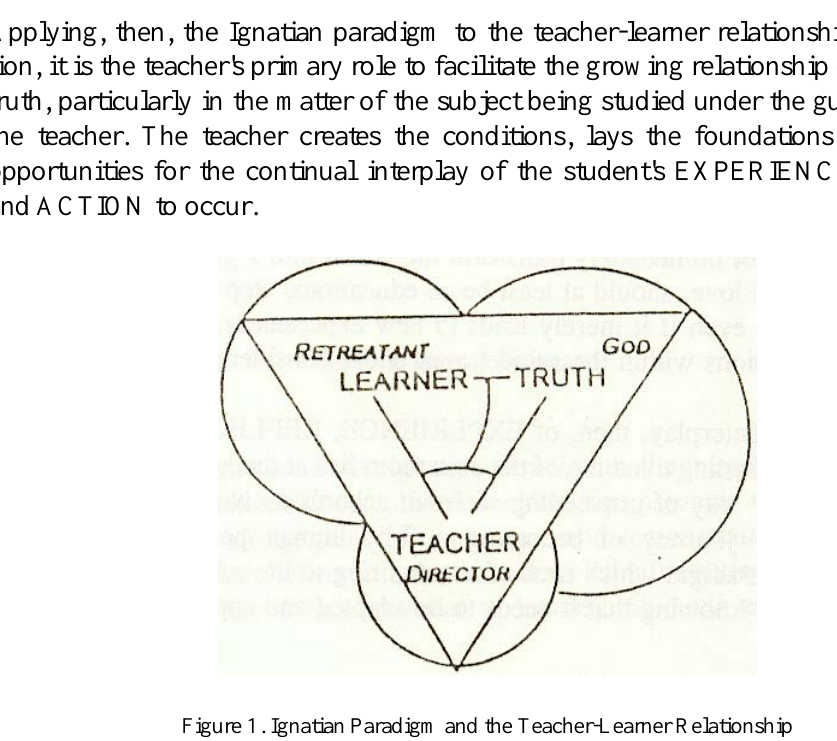
Figure 1. Ignatian Paradigm and the Teacher-Learner